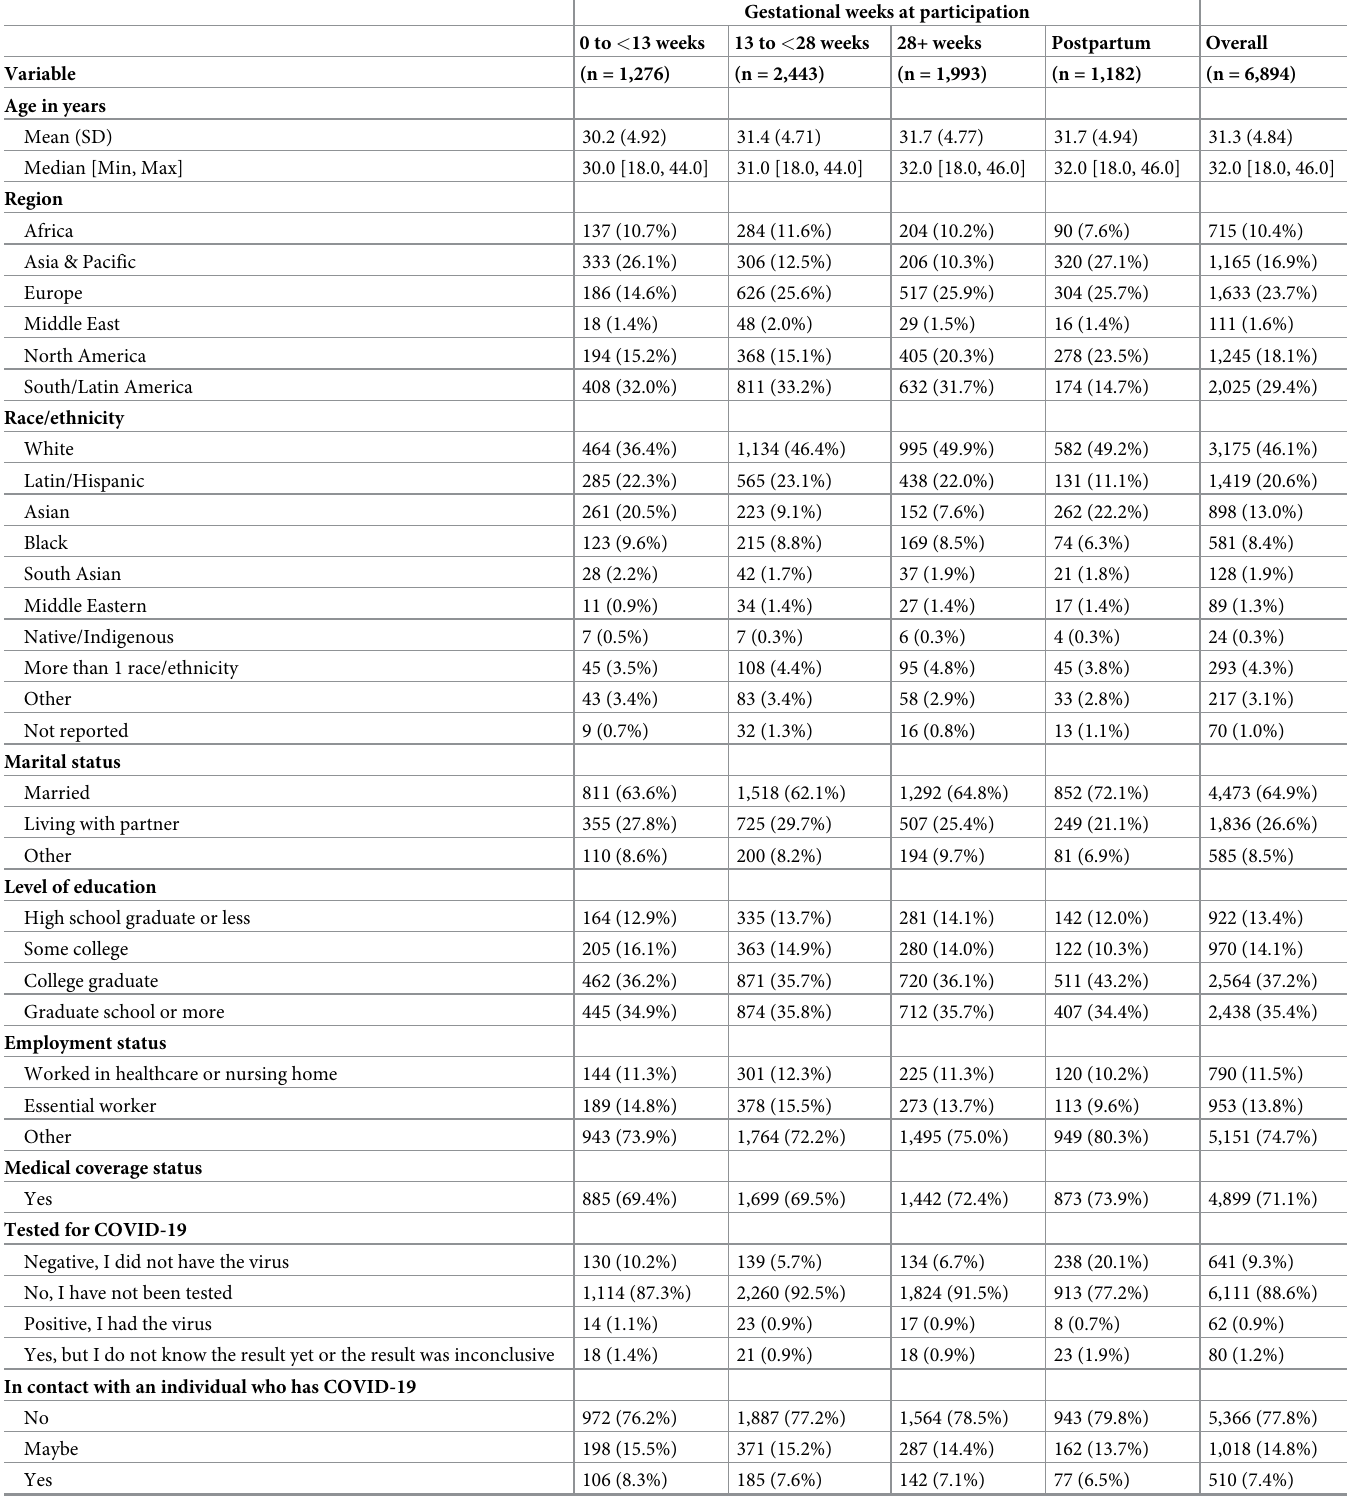
Table 1. Descriptive statistics for survey respondents in the analytic sample, overall and by pregnancy